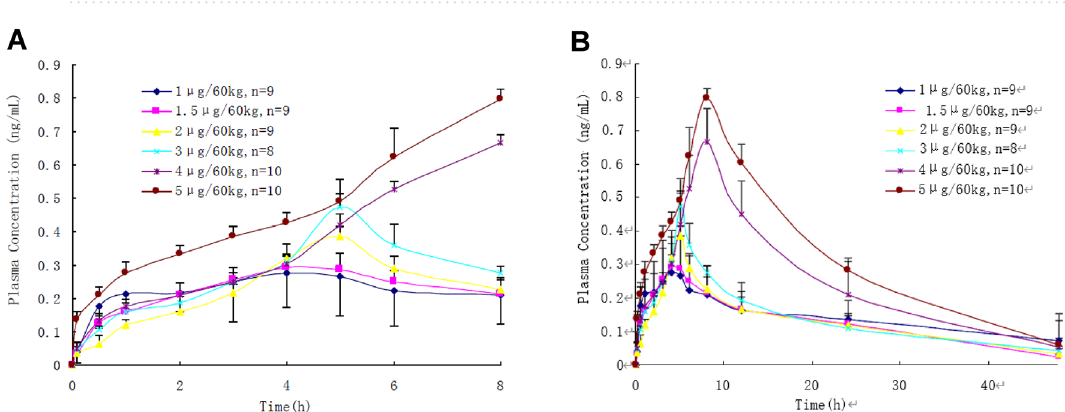
Figure 5. Plasma concentration–time curves of anfibatide in healthy volunteers after single intravenous bolus injection at dose levels of 1, 1.5, 2, 3, 4 and 5 µg/60 kg, respectively (Time = 0–8 h, A ; Time = 0–48 h, B ). Mean ±